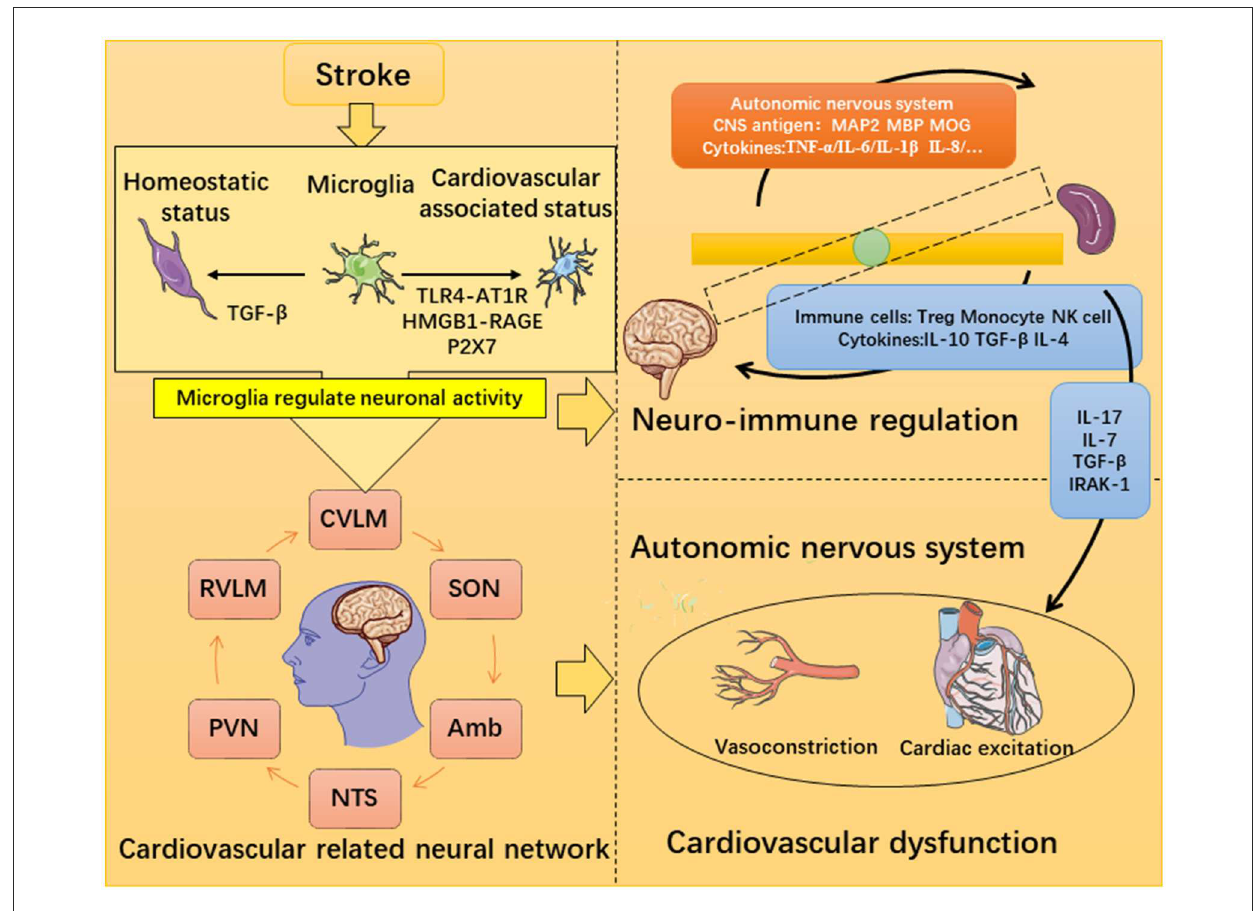
FIGURE4 Possible mechanism of microglia-mediated inflammatory destruction of neuro-cardiovascular